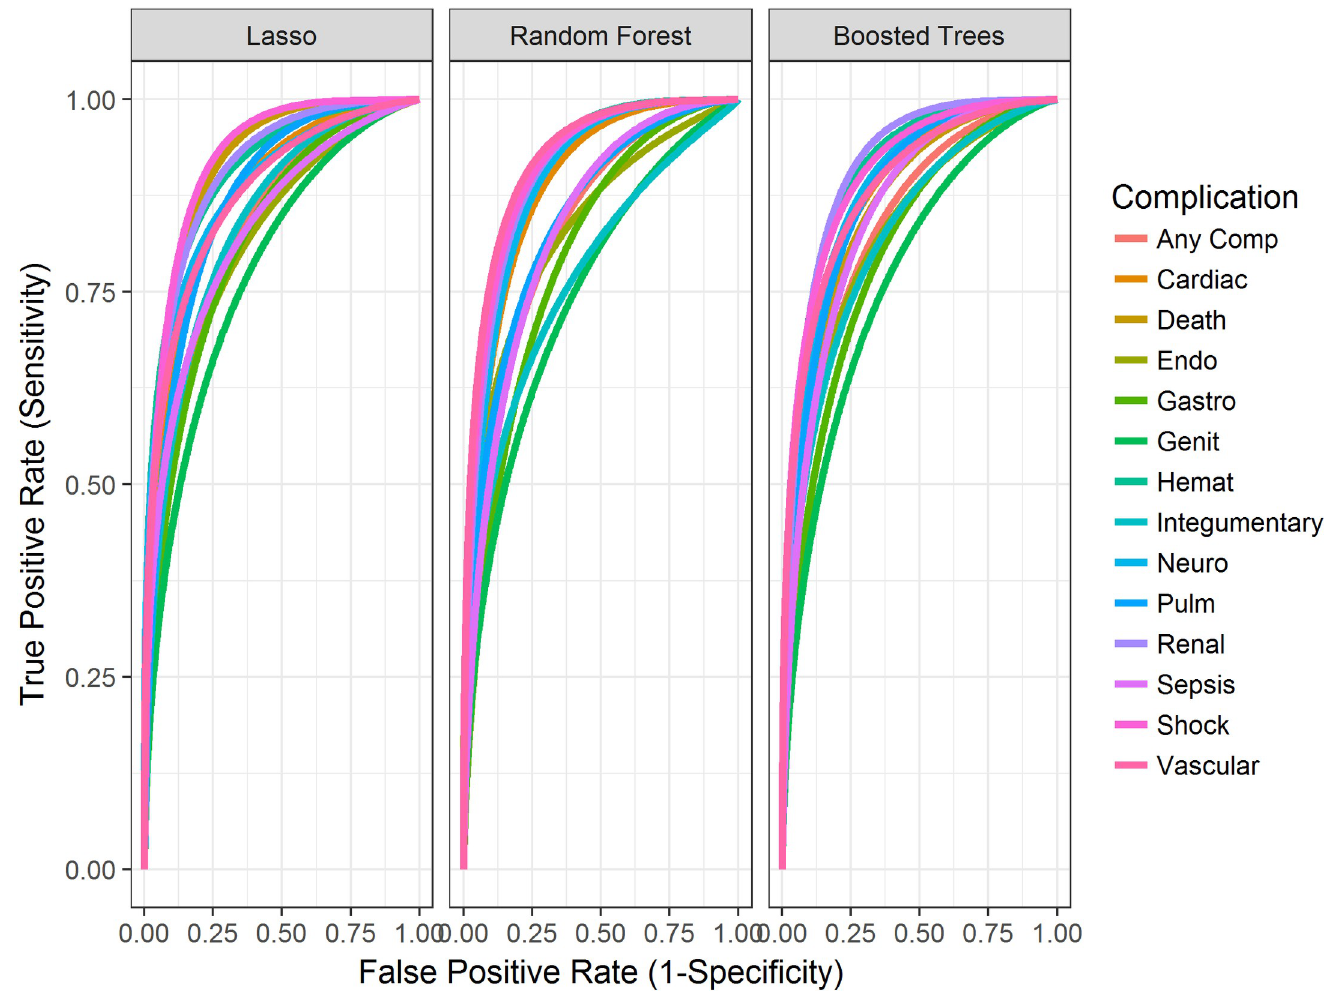
Fig 2. Graphs displaying the resulting receiver operator characteristic curves for each modeling method across all 14 complications. comp, complication; endo, endocrine; gastro, gastrointestinal; genit, genitourinary; hemat, hematological; lasso, least absolute shrinkage and selection operator; neuro, neurological; pulm,